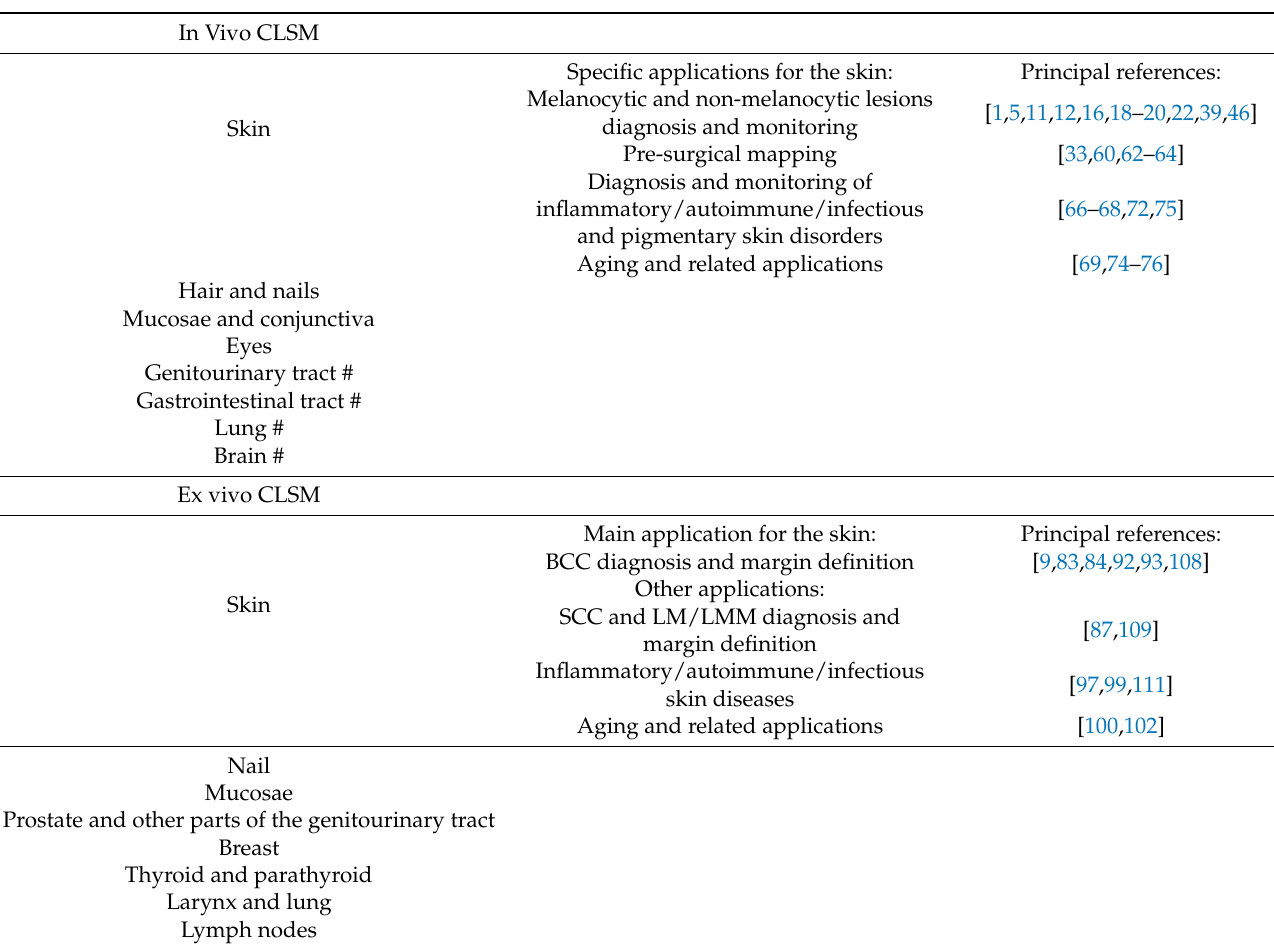
Table 1. Main applications of in vivo and ex vivo confocal laser scanning